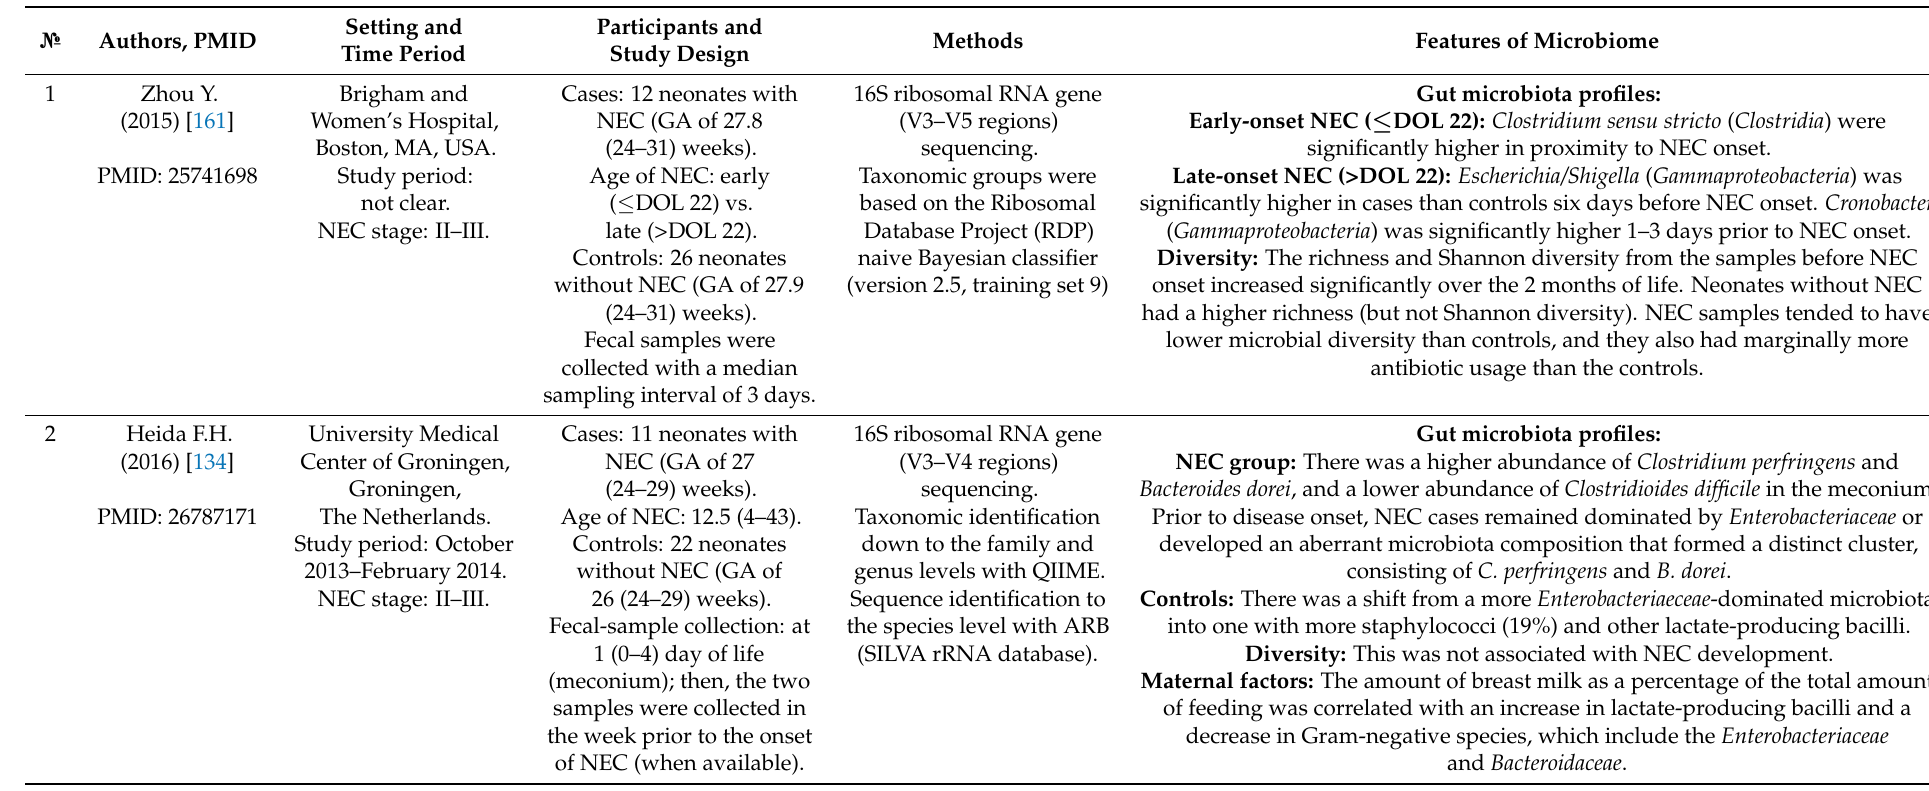
Table 4. Features of the intestinal microbiome in preterm